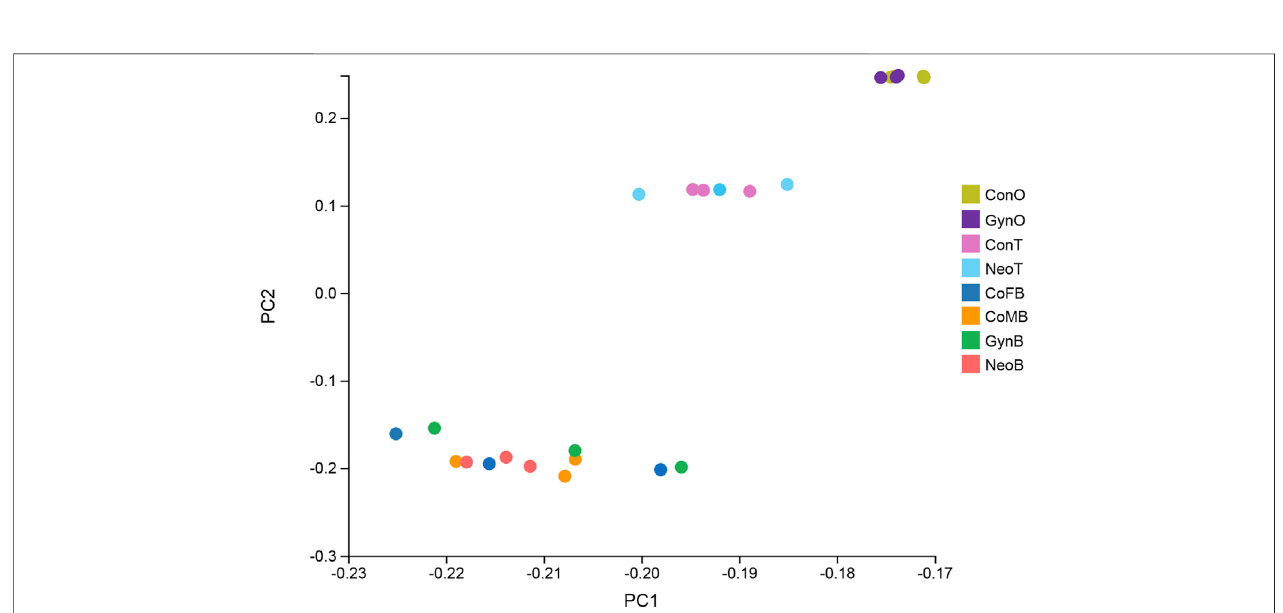
FIGURE 2 | Principal component analysis result of the RNA sequencing (RNA-seq) samples.